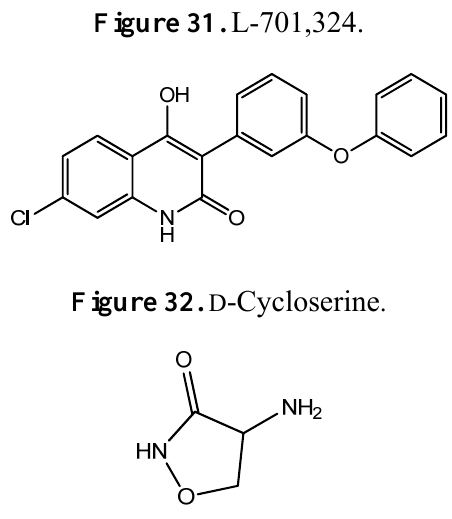
Figure 31. L-701,324.